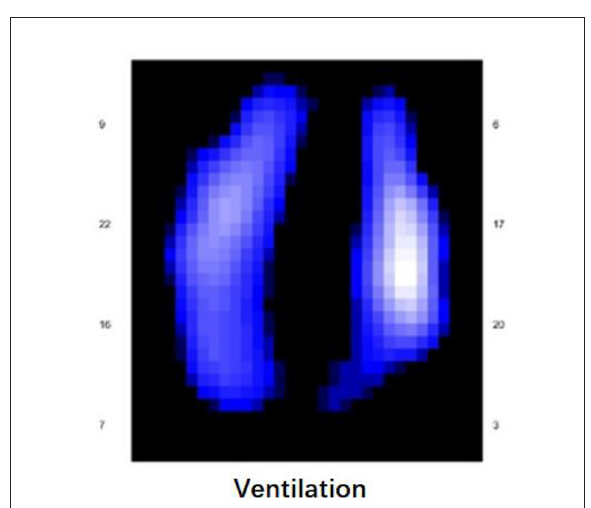
FIGURE3 The results of the EIT assessment of the patient’s lungs